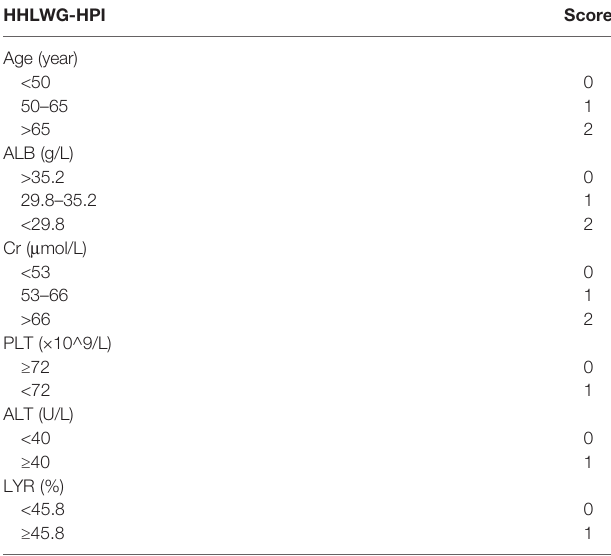
TABLE 3 | The HHLWG-HPI.